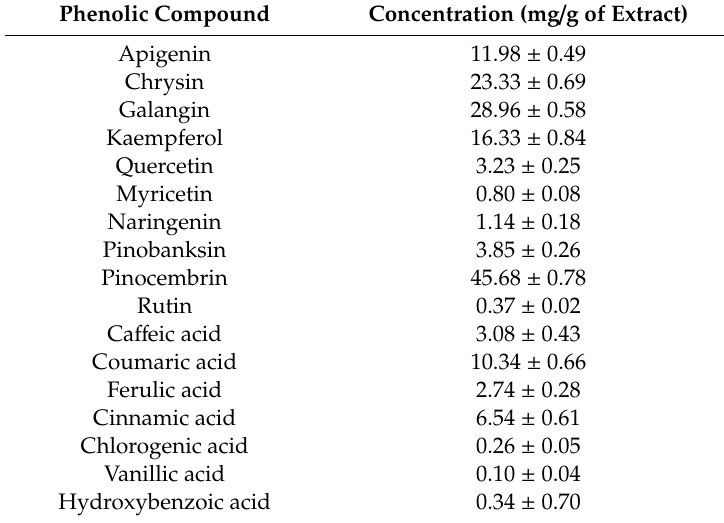
Table 3. Concentrations of the flavonoids and the phenolic acids in the propolis